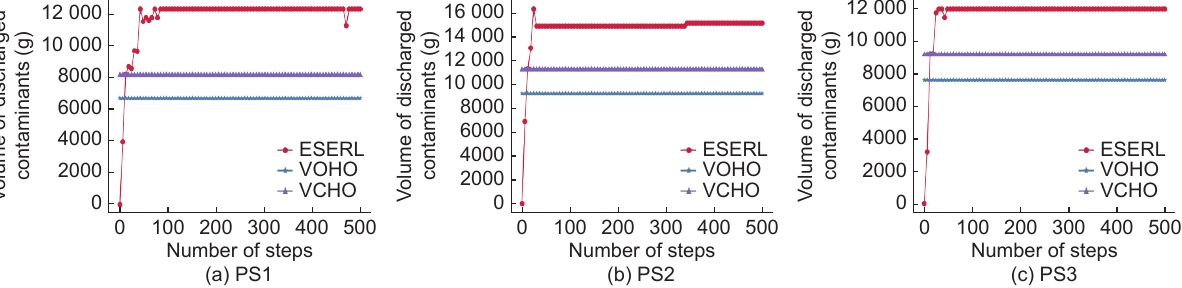
Fig. 5 Volume of discharged contaminants for different single polution events by ESERL, VCHO, and VOHO.